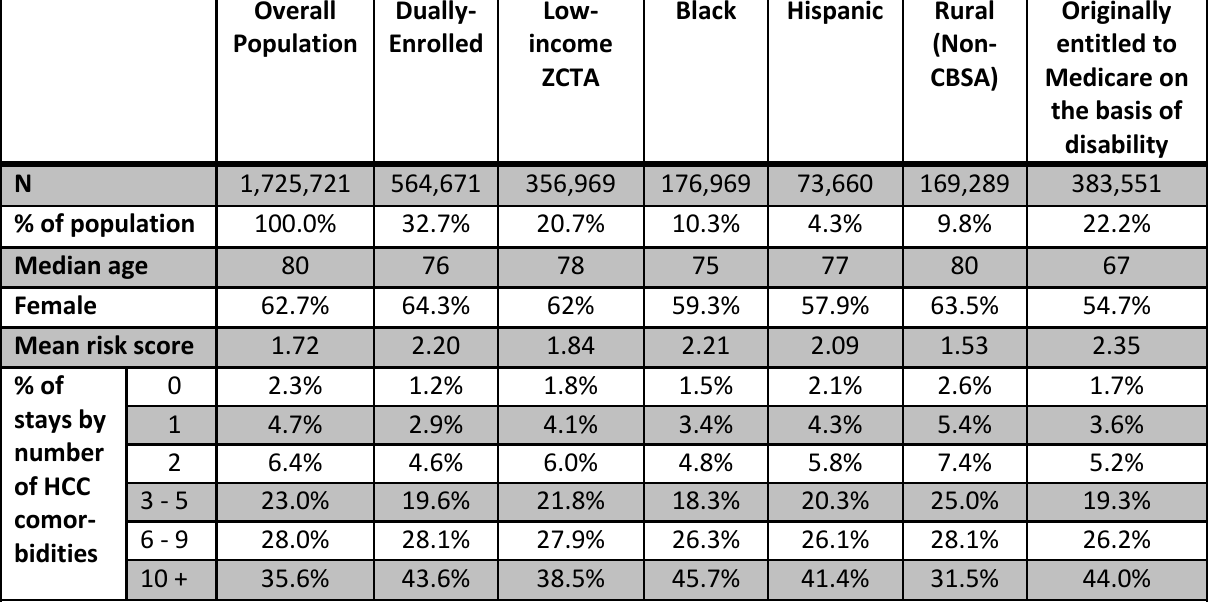
Table 12.1: SNF Beneficiary Population, Fiscal Year